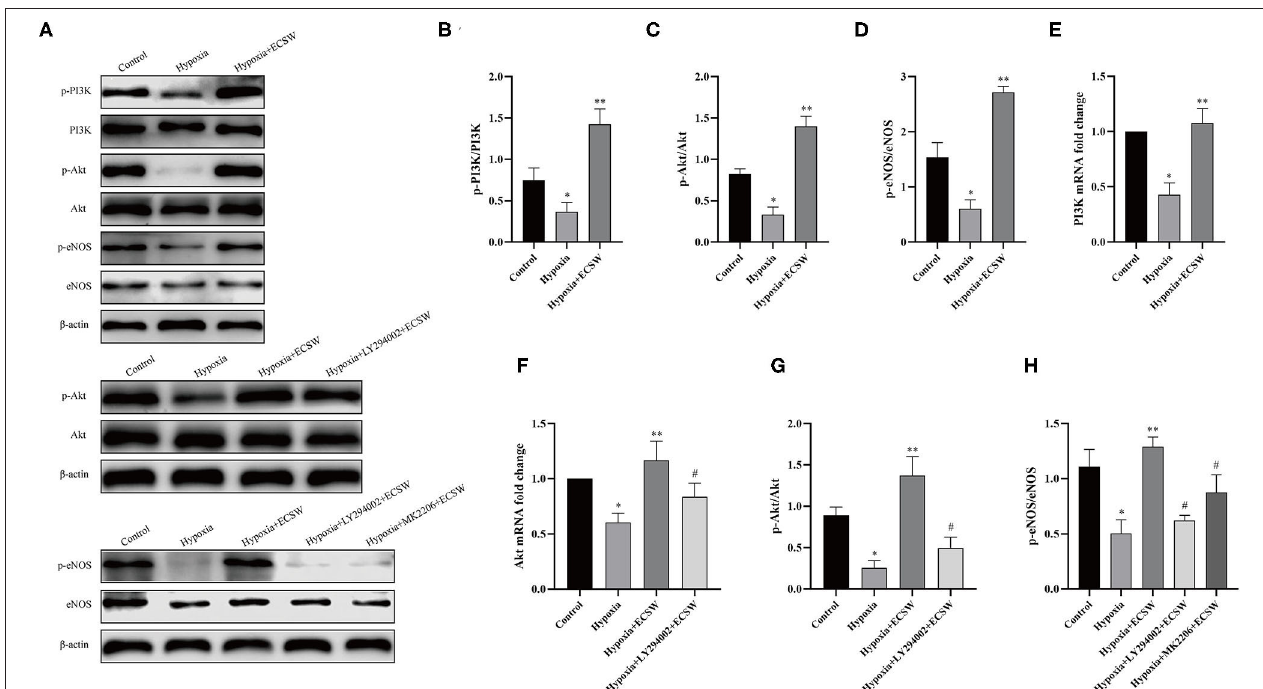
FIGURE 5 | ECSW improve PI3K/Akt/eNOS expression levels of EPCs after hypoxic injury. (A) The expression of p-PI3K, PI3K, p-Akt, Akt, p-eNOS, eNOS, and β -actin proteins in EPCs in each group. (B–D,G,H) Quantification analysis of p-PI3K, p-Akt, and p-eNOS proteins expression levels based on Western blotting analysis. (E,F) Quantitative analysis of mRNA levels of PI3K and Akt of EPCs in each group. Data are presented as mean ± SD, N = 3. * P < 0.05 vs. group control, ** P < 0.05 vs. group hypoxia, # P < 0.05 vs. group hypoxia +